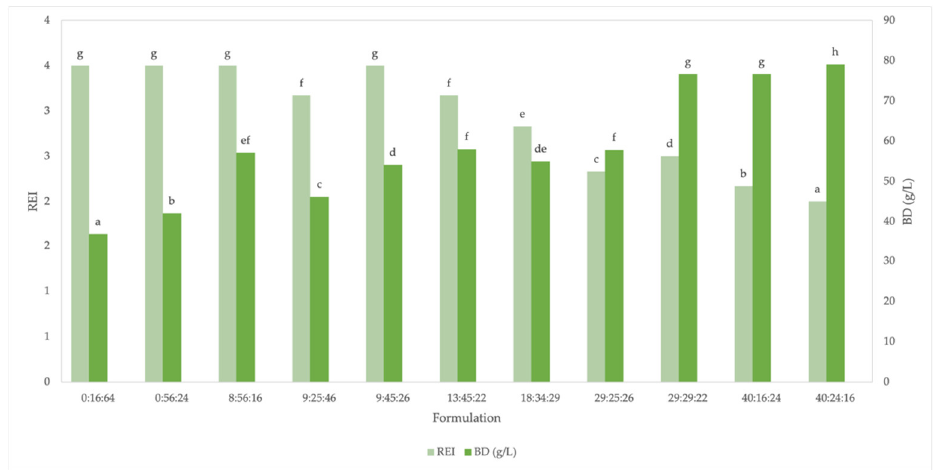
Figure 5. Radial expansion index (REI) and bulk density of extruded snacks with different proportions of flours (%okara: %mung bean: %rice). a–g Means with different letters within the same response are different ( p < 0.05; n = 3).